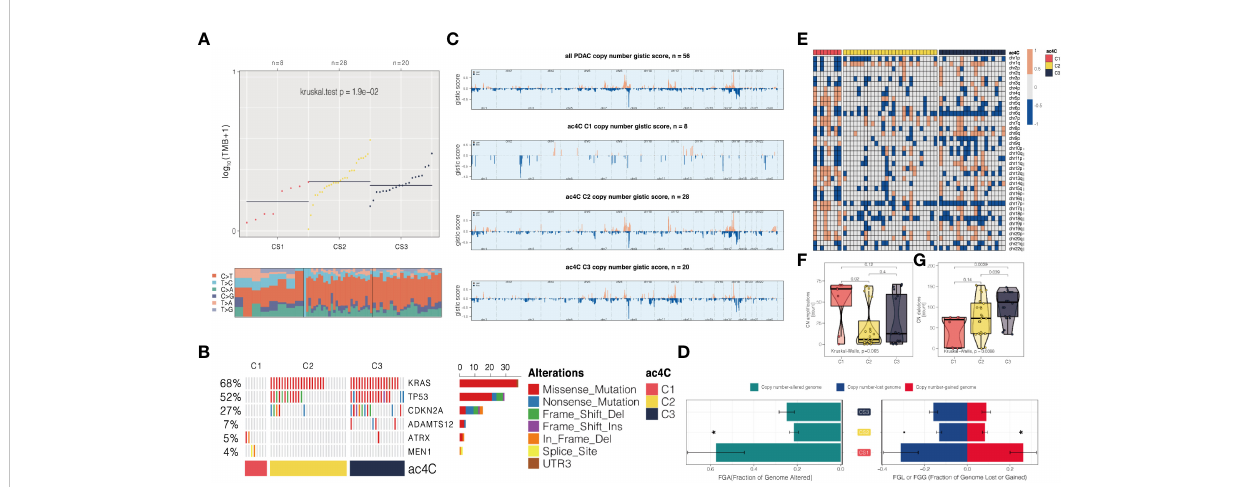
FIGURE 5 Three NAT10-relevant subtypes of PDAC in the TCGA cohort exhibit genomic heterogeneity and chromosomal instability. (A) An analysis of the distribution of TMB and TiTv (transition to transversion) among three subtypes is presented. (B) Onco printing showing the distribution of genes that were differentially mutated among three subtypes. (C) An overview of the CNA landscape across the entire cohort and among the NAT10-relevant subtypes. (D) An example of a barplot showing the distribution of FGA, FGG, and FGL. Bar charts are presented as means with standard errors of the means. (E) Heatmap showing arm-level CNA among three subtypes. Distribution of focal-level copy number ampli fi cations and deletions across three subtypes were shown in (F, G) , respectively.